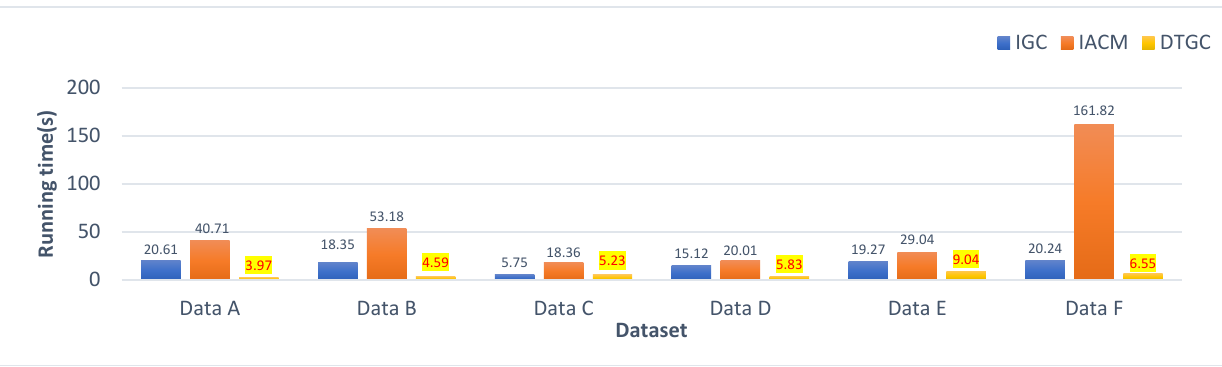
Figure 10. The comparison of Gamma distribution (green) and Gaussian distribution (red) for fitting the intensity histogram of Data F. Table 4. Algorithm complexity.